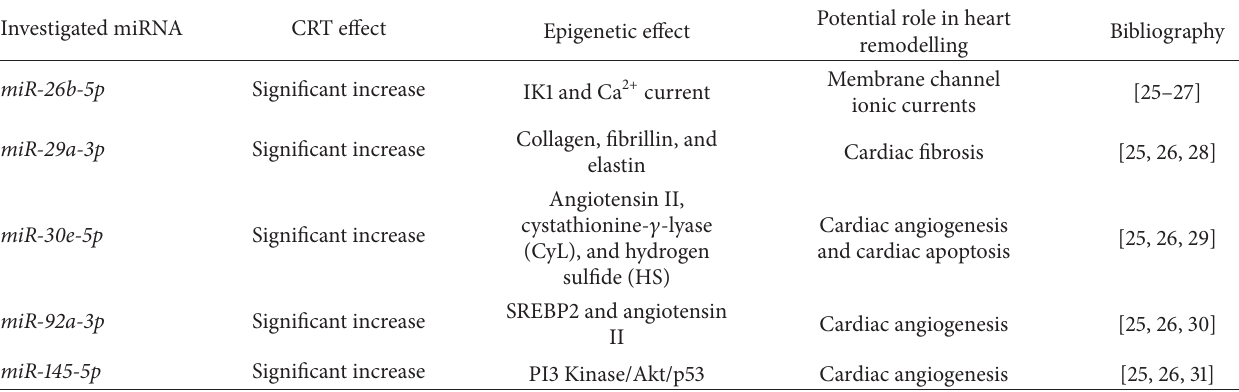
Table 2: In this table, the representation of microRNA (miR), cardiac resynchronization therapy (CRT) effect on miRs expression, the miR’s epigeneticeffect,andthepotentialroleinheartremodellingisdisplayed.Ontherightcolumn,thebibliographyreferenceforeveryinvestigated miR is represented. IK1 is inward-rectifier K + current; SREBP2 is sterol regulatory element-binding protein 2 (an oxidative